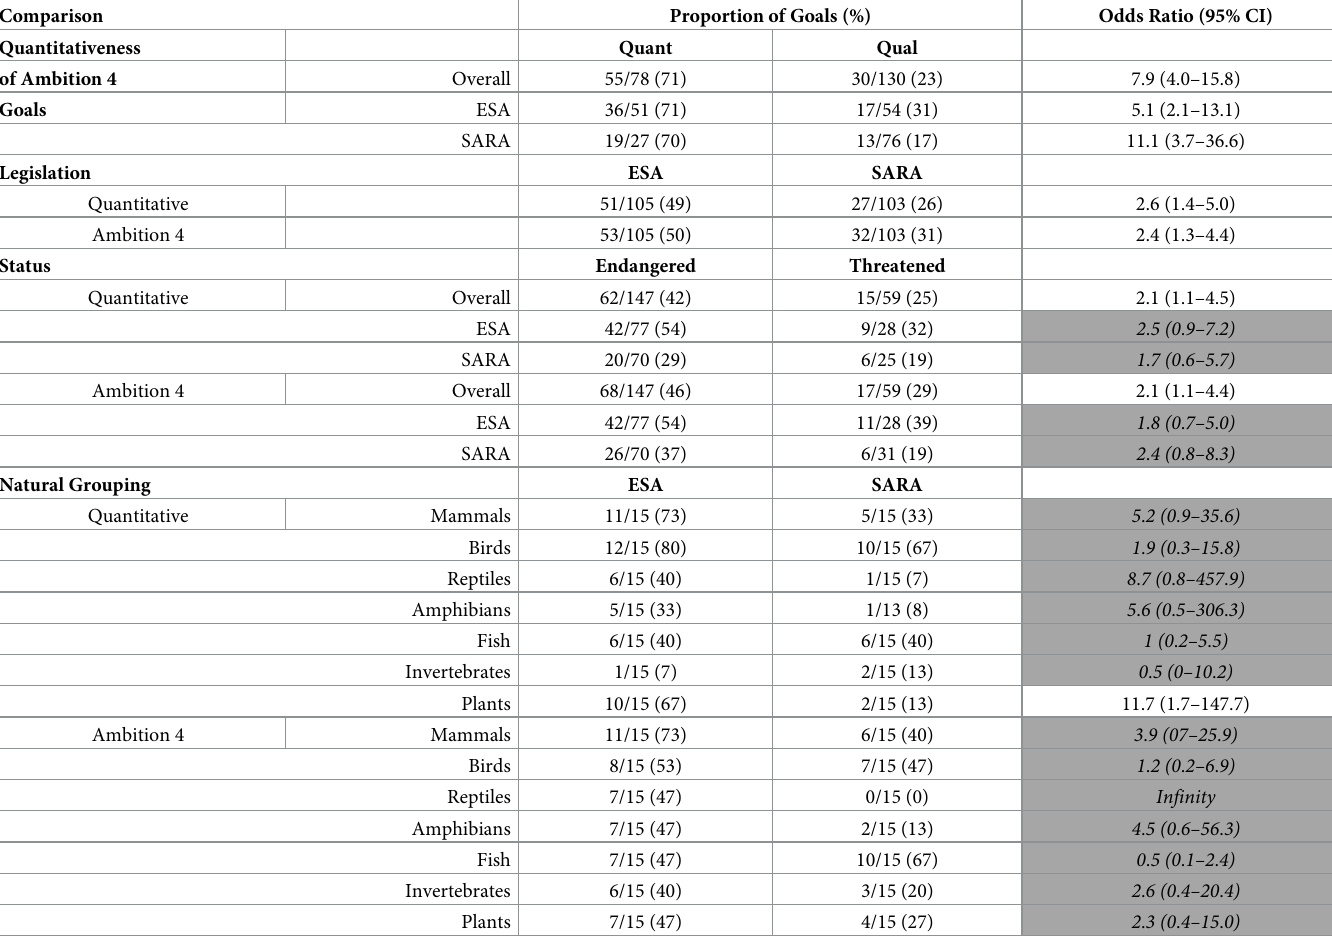
Table 2. Comparisons of the quantitativeness and ambition of recovery goals (n = 208) by legislation, status, natural grouping, and habitat. Odds ratios and confi- dence intervals were obtained from Fisher’s Exact Tests. See Methods for further detail. Cells shaded grey with italicized text denotes odds ratios with confidence intervals that overlap one (i.e., include the possibility of no